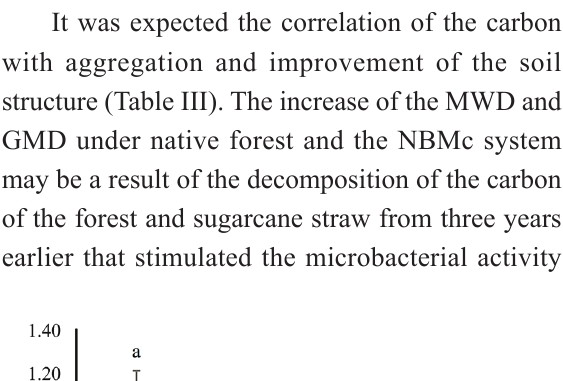
Total organic carbon content in a medium-textured dystrophic Red Latosol in a fragment of native forest (NF) and in sugarcane cropping areas under the sugarcane with burn and manual harvest (BMn), sugarcane with burn and mechanized harvest (BMc) and sugarcane without burn and mechanized harvest (NBMc). Treatment